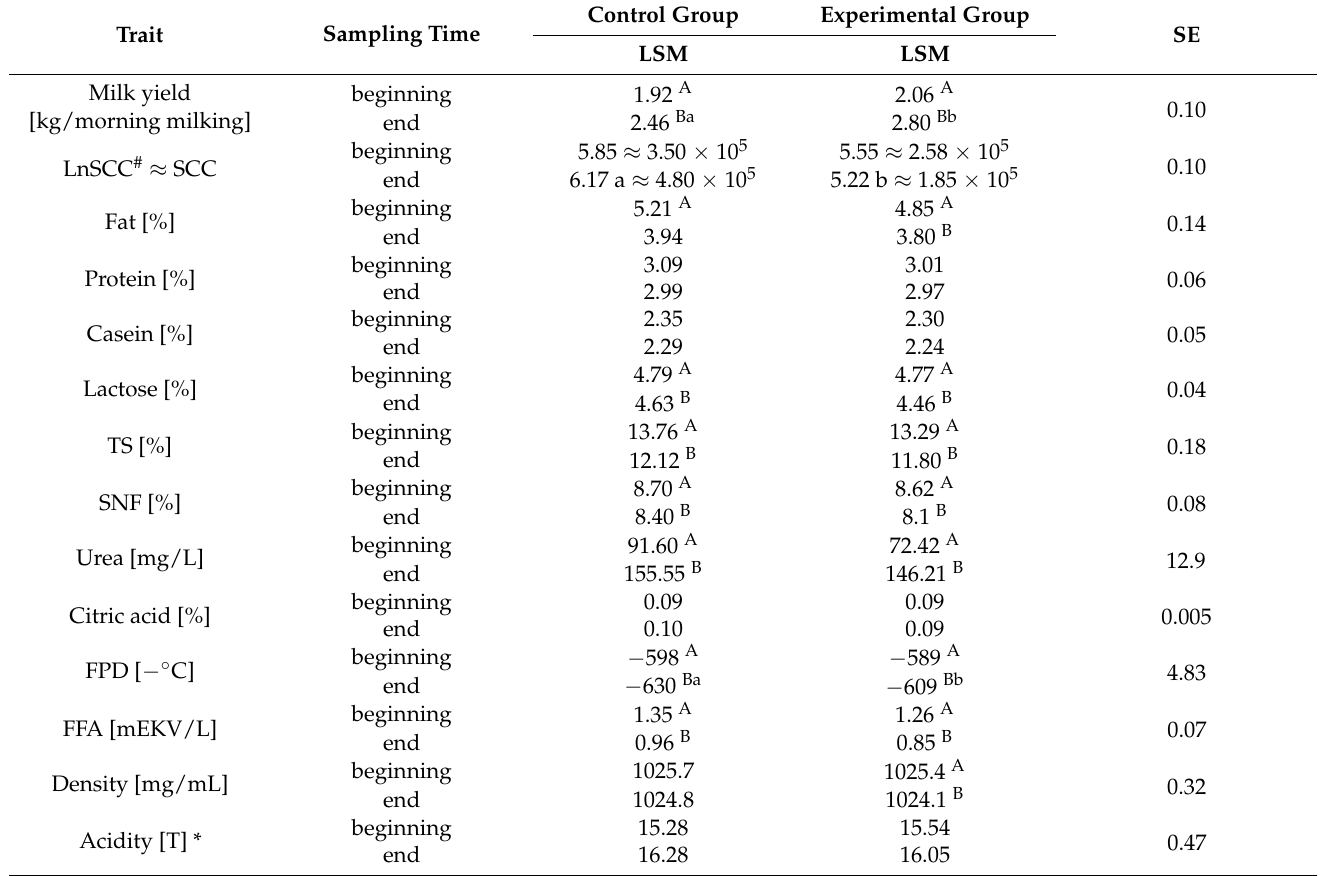
Table 2. Yield and composition of milk from morning milking in Herd I at the beginning and end of the